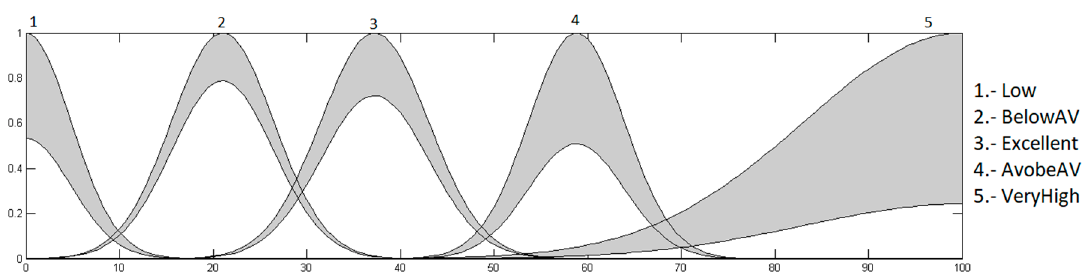
Figure 29. Optimized input heart rate with Gaussian MFs.